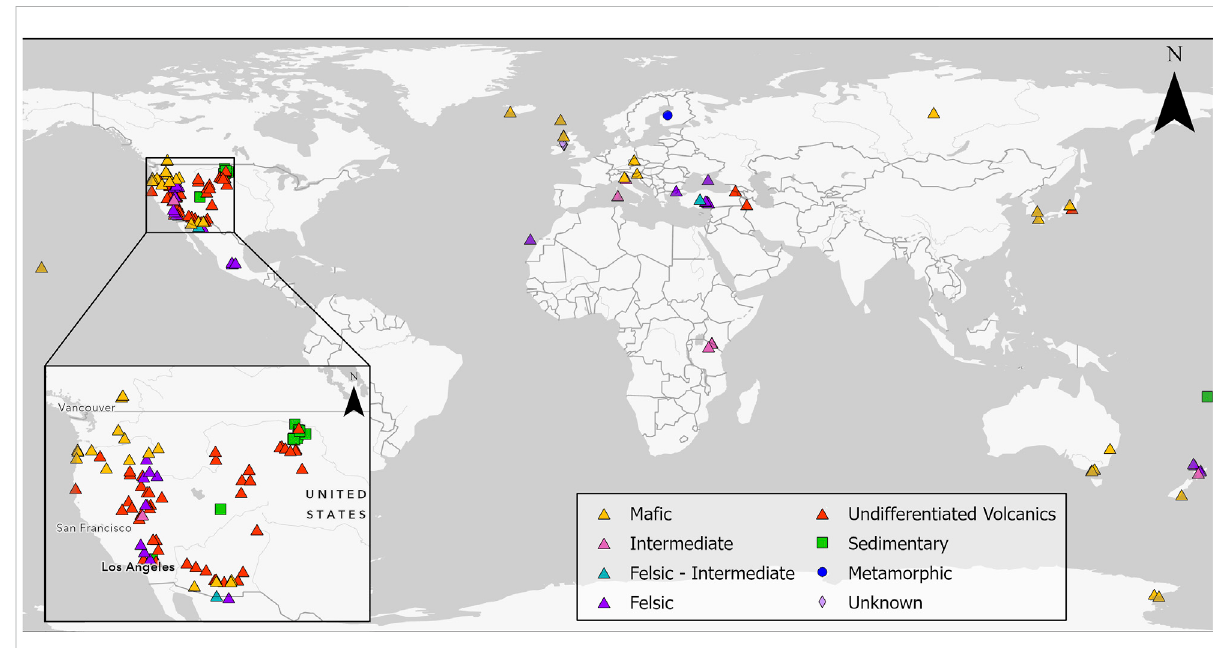
FIGURE 1 Global geological occurrence of erionite, with western North America, a particular focus of studies, shown in the inset map; sites are coded by geology. Details on the studies related to each location can be found in Supplementary Material